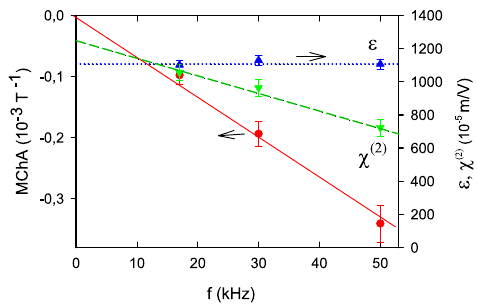
Fig. 3 Frequency dependence. Frequency dependence of the magnetochiral anisotropy (MChA, red balls), the dielectric constant (blue up triangles) and the SHG hyperpolarizabiltiy (green down triangles) of a + poled TGS sample at 320.90 K. Electric fi eld 10 V/mm, B = 2 T. Lines are linear fi ts.